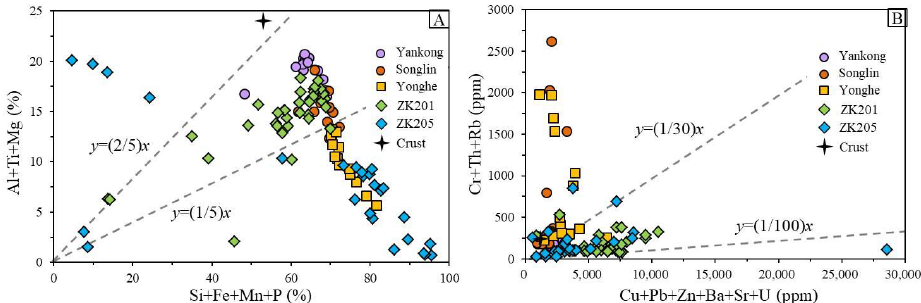
Figure 5. Relationships between different ( A ) major element sets and ( B ) trace element sets for the Early Cambrian black shale. Early Cambrian black